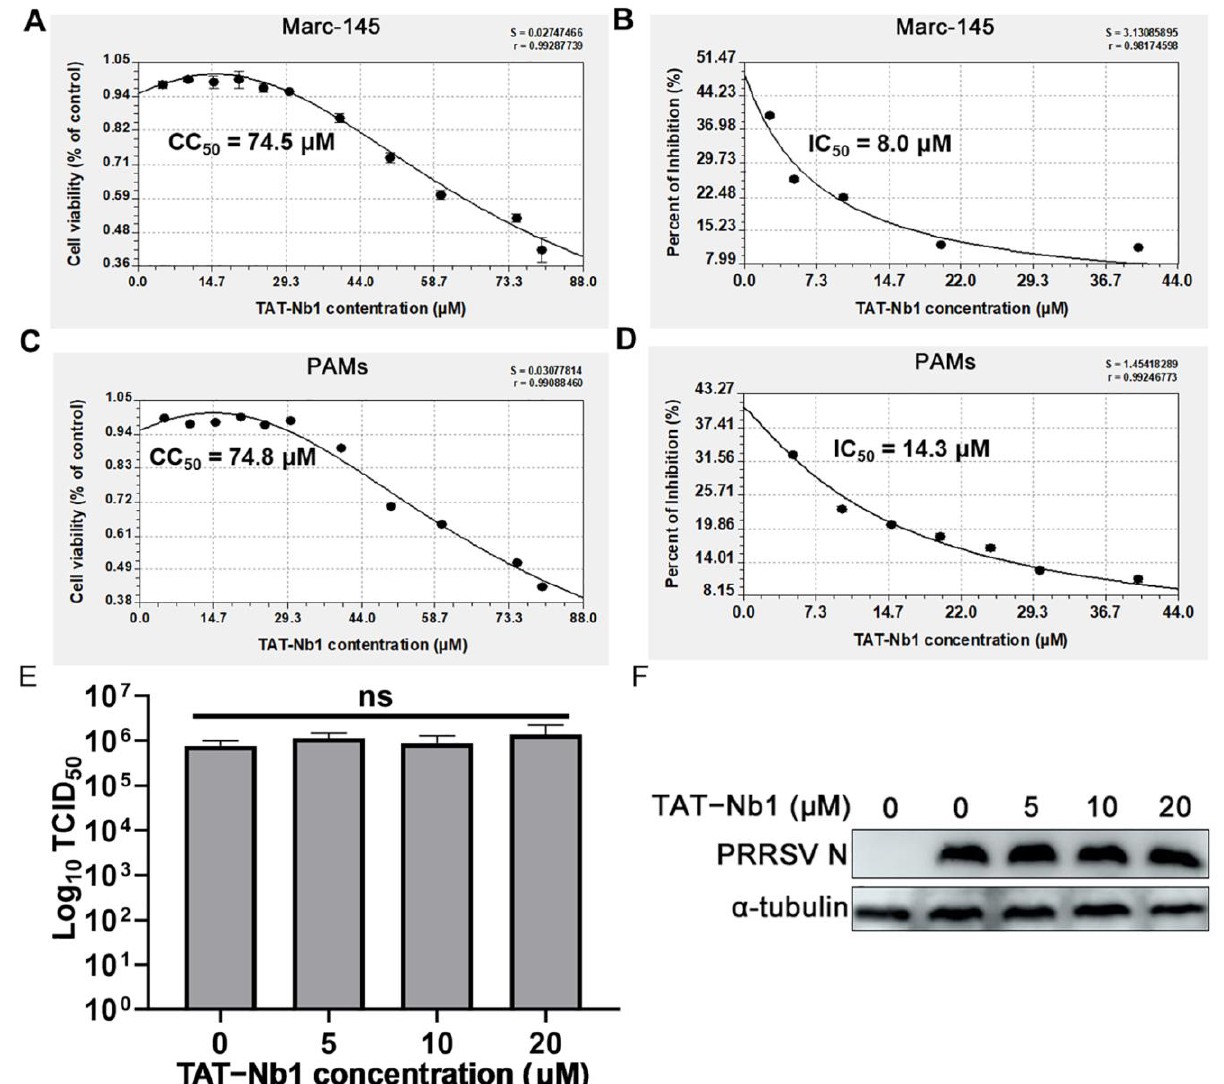
Figure 6. The CC 50 and IC 50 values of TAT - Nb1 in Marc - 145 cells and PAMs. Marc - 145 cells ( A ) or PAMs ( C ) were treated with various concentrations of TAT - Nb1 for 36 h and then subjected to CCK - 8 assay. The viability curve and CC 50 values were generated using CurveExpert software. Marc - 145 cells ( B ) or PAMs ( D ) were treated with various concentrations of TAT - Nb1 for 6 h, then cells were infected with PRRSV (0.1 MOI) for 36 h. IFA was performed, and the inhibition curve and IC 50 was generated using ImageJ and CurveExpert software. ( E , F ) PRRSV suspension (100 TCID 50 ) was co - incubated with TAT - Nb1 at 37 °C for 1 h and inoculated to Marc - 145 cells, and part of the supernatant was used to determine the virus titers directly. After 24 h, cells were harvested for viral replication analysis, and virus titer was tested using TCID 50 . Data are expressed as the means ± standard deviations (SD) of the results of three independent experiments. P values were calculated using analysis of variance (ANOVA). ns, not significant.